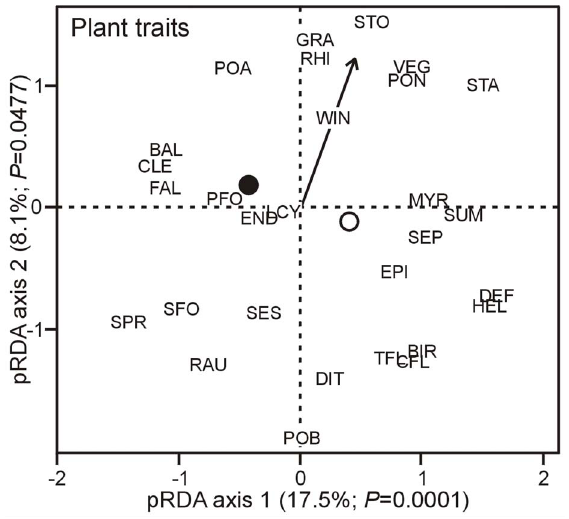
Figure 2. Plant trait response to deer density and vegetation cover type. Partial redundancy analysis showing the response of plant traits to deer density (arrow) and vegetation cover types (black circle = uncut forests; white circle = cut-over areas). Blocks were used as a co- variable. See Table 1 for trait names